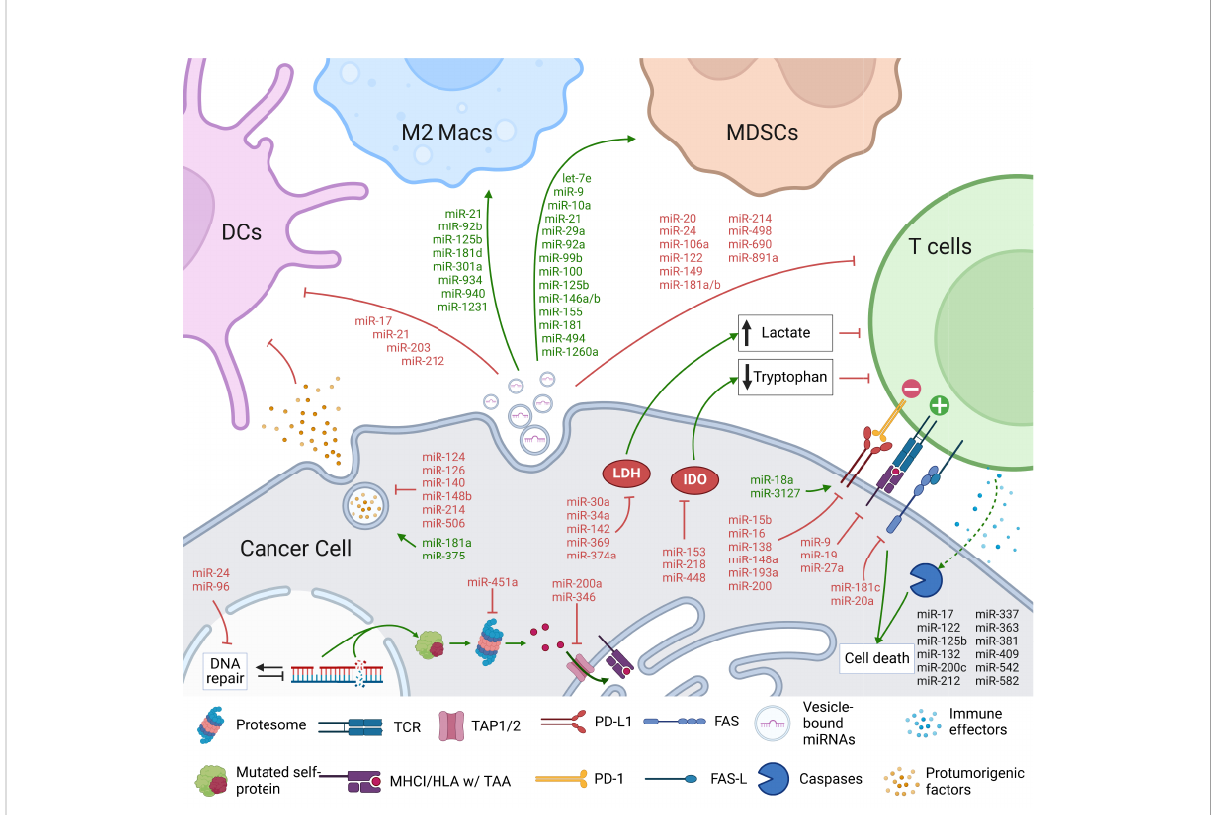
FIGURE 7 Tumor cell miRNAs regulate immune and cancer cell functions, in fl uencing various aspects of anti-tumor immunity. Tumor-cell expressed miRNAs regulate various aspects of the anti-tumor immunity. Studies have shown that miRNAs can impact tumor antigenicity by controlling DNA repair and antigen presentation machinery. Furthermore, miRNAs can inhibit mediators of cell death, including caspases and death receptors, to prevent immunologic cell death. miRNA-mediated control of immunomodulatory cytokines and metabolic mediators such as lactate dehydrogenase (LDH) and indoleamine 2 3-dioxygenase (IDO) can alter the immune landscape within the tumor microenvironment. Importantly, tumor-derived miRNAs can be transported via extracellular vesicles into a variety of immune cells, including dendritic cells (DCs), macrophages (Macs), myeloid-derived suppressor cells (MDSCs), and T cells, and regulate their functions. Several miRNAs regulate multiple pathways simultaneously, suggesting that the critical miRNA regulatory hubs can be targeted to potentiate anti-tumor